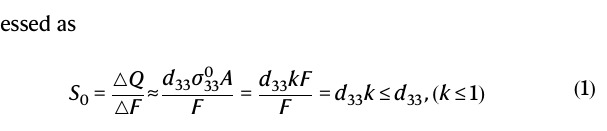
Fig. 1| Concept,structureand sensing performanceoftheRSHTS. a Illustration of human body and anatomical structure of fi nger. b Finger-inspired rigid-soft hybrid piezoelectric tactile sensor array. c Differences of piezoelectric fi lm defor- mation and working mode between our tactile sensor and existing